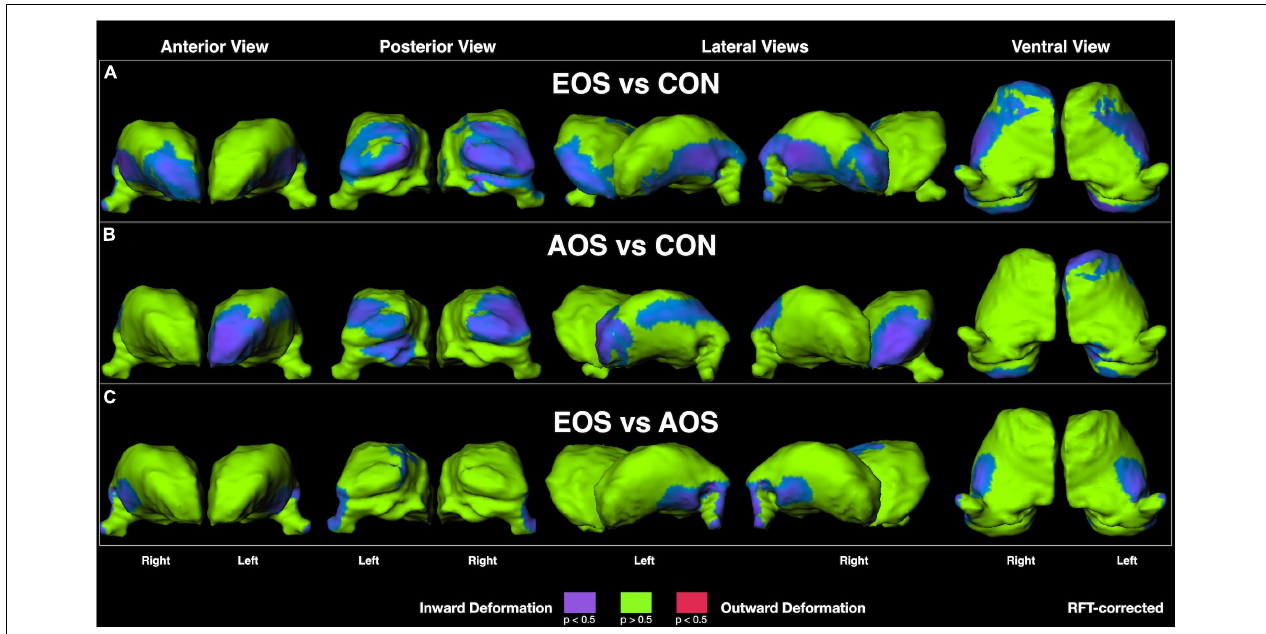
FIGURE 1 | Thalamic surface shape displacement maps between: (A) Early-Onset Schizophrenia (EOS) patients and control (CON) participants; (B) Adult-Onset Schizophrenia (AOS) patients and CON participants; and (C) EOS and AOS patients. Cooler colors indicate significant regions of inward shape differences and warmer colors indicate significant regions of outward shape differences corrected for multiple comparisons using random field theory